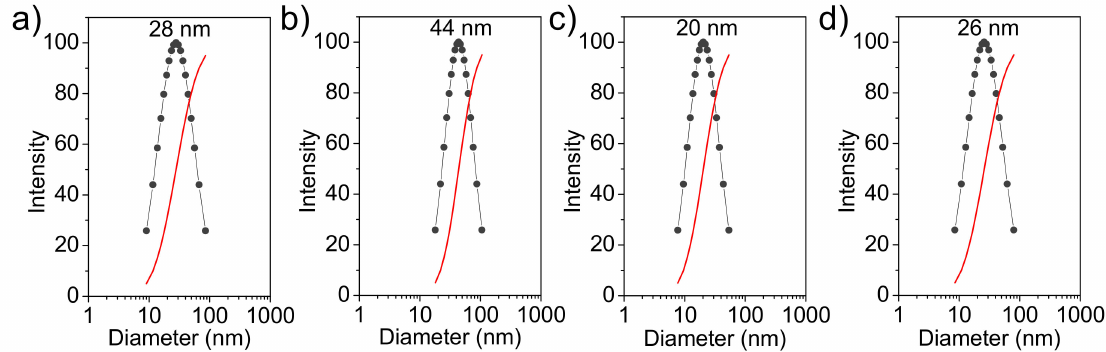
Figure 5. Nanoparticle diameter distribution determined by DLS for: ( a ) ACP, ( b ) ACP-CAM, ( c ) cHAp and ( d ) cHAp-CAM. Size distribution (black line) and measure correlation functions (red line).